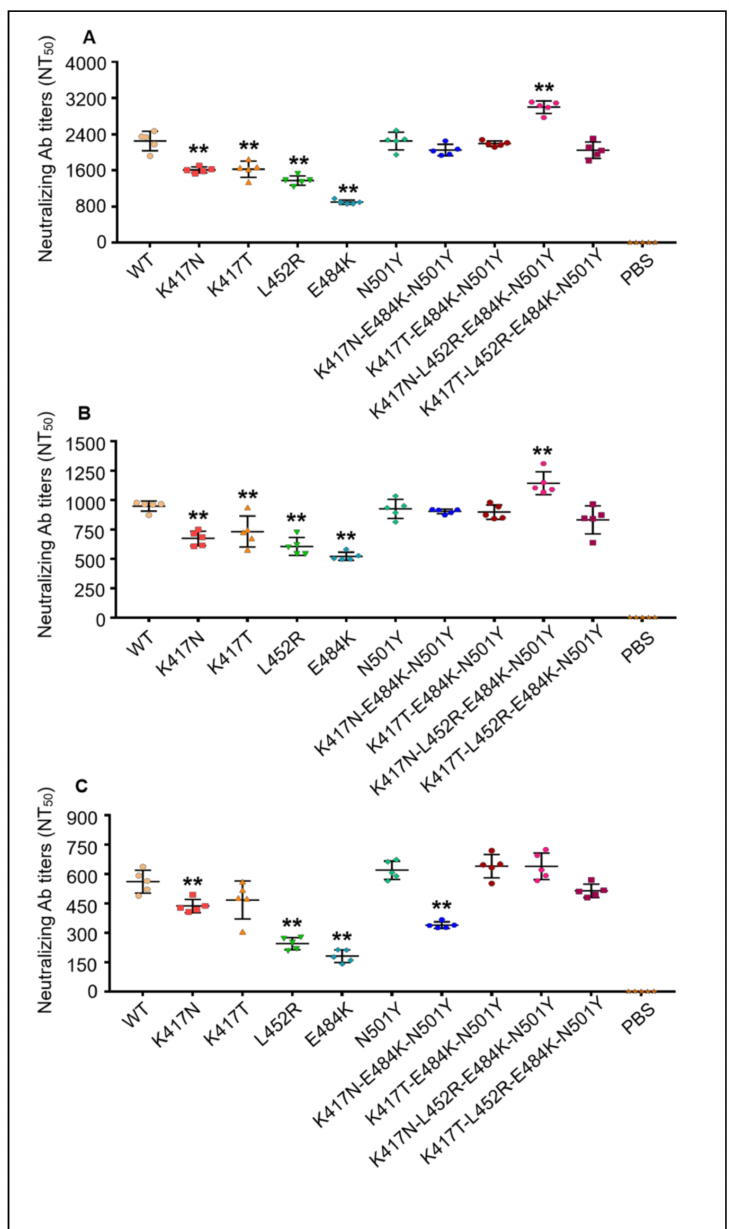
Figure 4. Mutant RBD-Fc proteins of SARS-CoV-2 induced the production of high-level cross- neutralizing antibodies in mice. Mice sera were collected from each immunized BALB/c mice at 7 days after final vaccination, subjected to a series of dilutions, and used in the neutralization experiments of SARS-CoV-2 pseudoviruses. The neutralizing antibody titer in each immunized group was defined as the sera dilution times by which the viral infectivity was neutralized by 50% (NT 50 ). Each dot represented the NT 50 value of each individual mouse, and the data were presented as mean ± SD for five mice in each group. ( A ) Neutralizing antibody titers against the SARS- CoV-2 pseudoviruses expressing wild-type S protein; ( B ) neutralizing antibody titers against the SARS-CoV-2 pseudoviruses expressing mutant S protein of K417N-E484K-N501Y (B.1.351 lineage); ( C ) neutralizing antibody titers against the SARS-CoV-2 pseudoviruses expressing mutant S protein of K417T-E484K-N501Y (P.1 lineage). ** ( p < 0.01) means significant differences between the mutant RBD-Fc protein booster group and wild-type RBD-Fc protein vaccination group. WT: the mice group immunized three times with wild-type RBD-Fc protein; PBS: negative control group injected with PBS plus